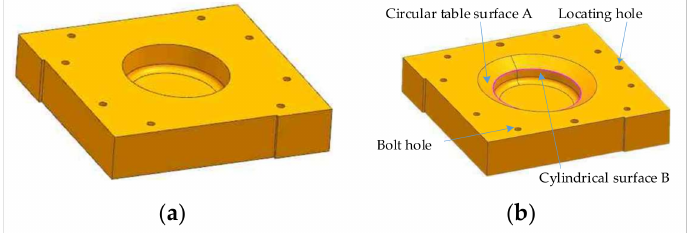
Figure 24. Support model: ( a ) for traditional multistage forming; ( b ) for the proposed